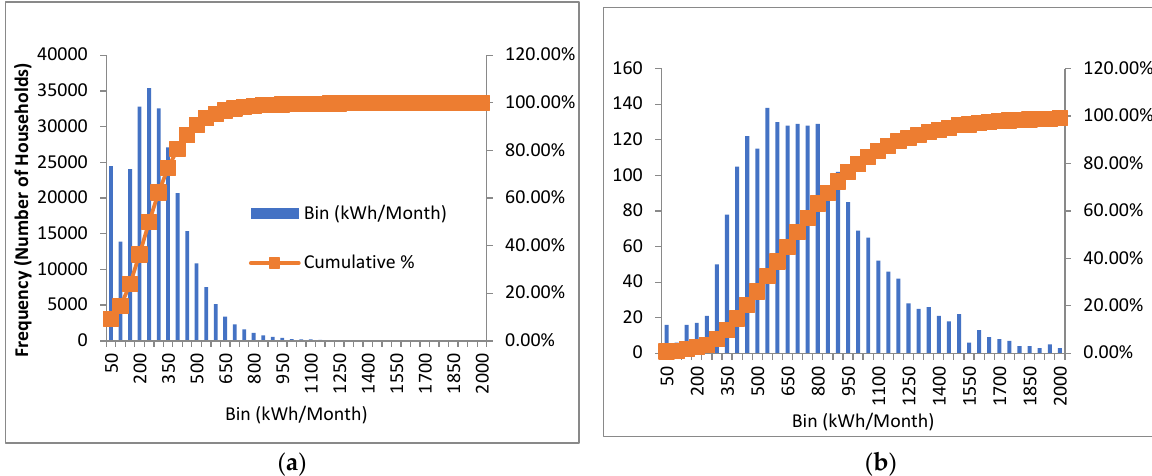
Figure 8. Energy consumption in February: ( a ) Ordinary households; and ( b ) Subsidised households. During the spring months of March, April, and May, the ordinary group had lower electrical energy usage. Specifically, 62%, 65%, and 64% consumed less than 300